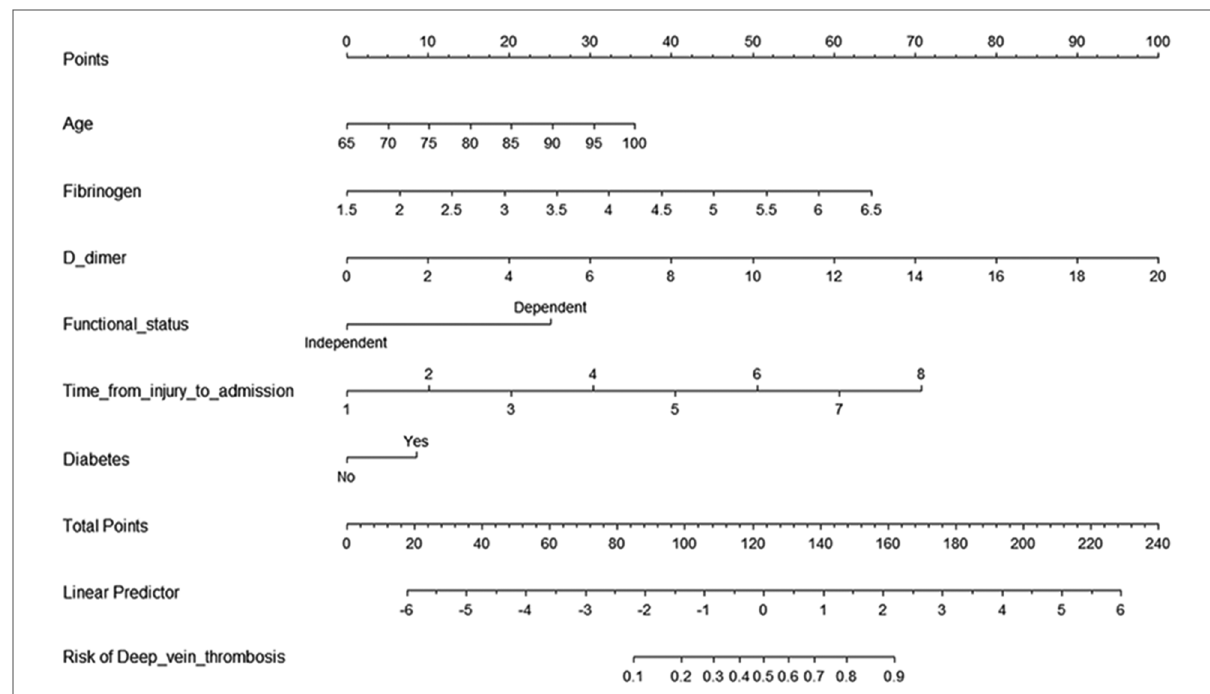
FIGURE 1 Predictive nomogram for deep venous thrombosis . To use the nomogram, the points corresponding to each prediction variable were obtained, then the sum of the points was calculated as the total score, and the predicted risk corresponding to the total score was the probability of